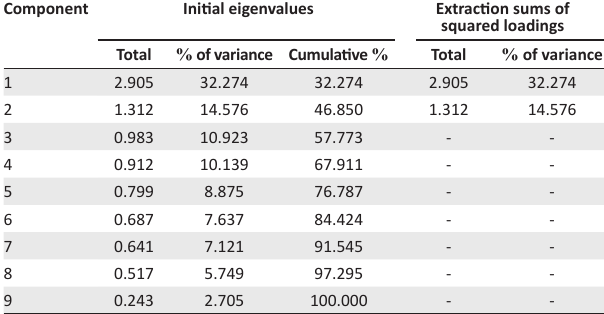
TABLE 6: Overall financial literacy scores. Financial knowledge